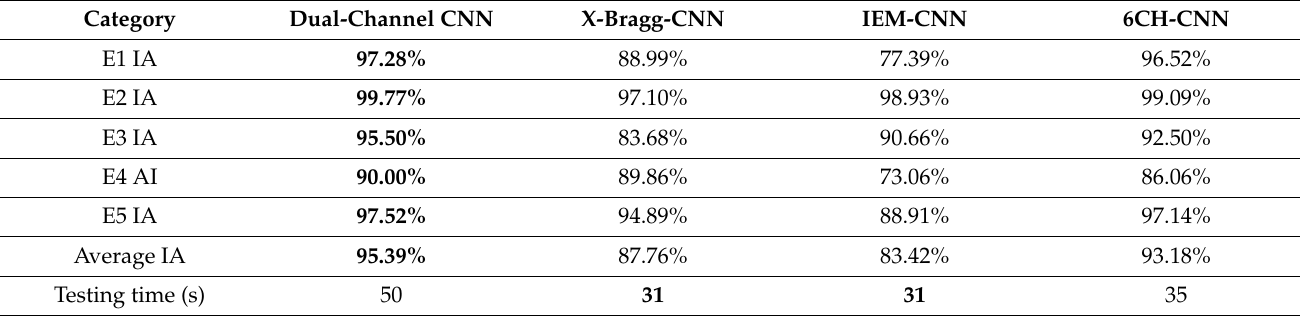
Table 10. Classification result of the dual-channel CNN, X-Bragg-CNN, IEM-CNN, and